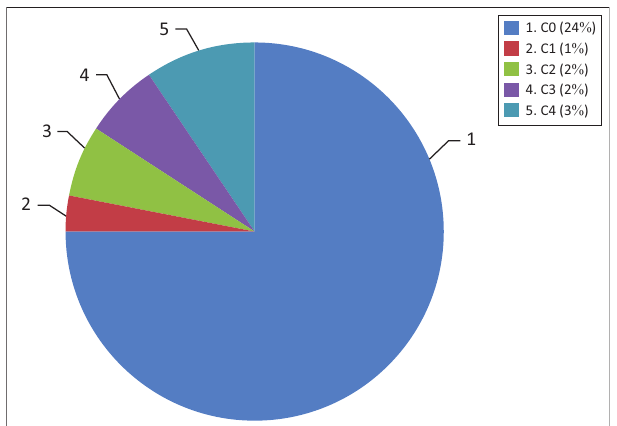
FIGURE 3: Relationship between the Villalta score and the VEINES-QoL/Sym score. TABLE 4: Clinical, etiology, anatomic and pathology compared with